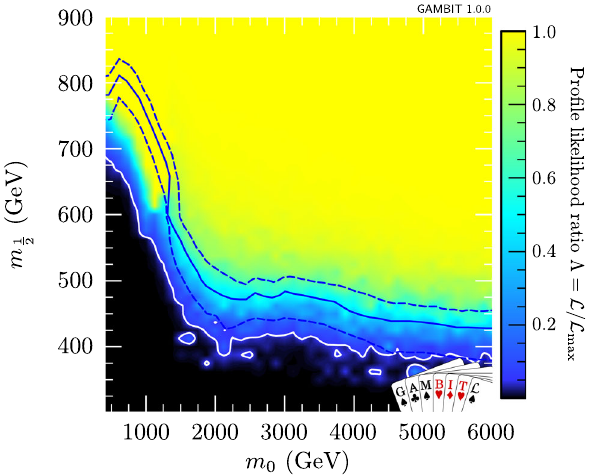
Fig. 1 Colour map showing the profile likelihood ratio L / L max for a ColliderBit scan over the CMSSM model defined by m 0 and m 1 / 2 , with tan β = 30, A 0 = − 2 m 0 and μ > 0, using the ATLAS zero- √ s = 8 TeV data [2]. lepton supersymmetry search likelihood from The solid white line indicates the 95% CL exclusion contour found with G AMBIT 1.0 [3] using LO cross-sections. The solid blue line shows the corresponding ATLAS 95% CL observed exclusion limit with NLO+NLL cross-sections, with dashed blue lines showing the ± 1 σ theoretical cross-section uncertainty. Reproduced from Fig. 3 in Ref.